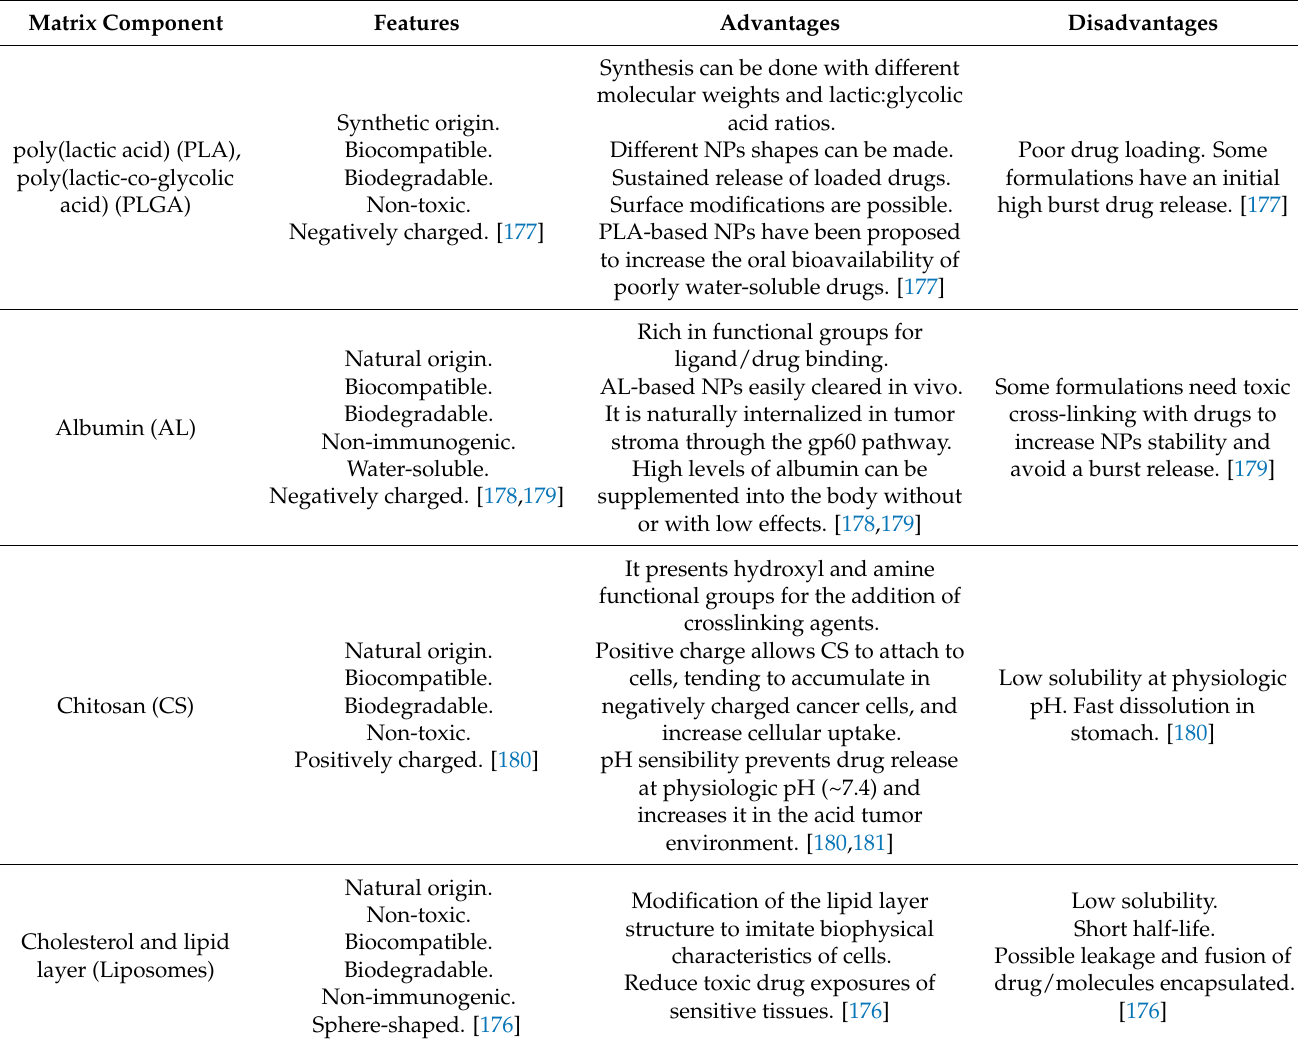
Table 2. The most common matrices for NPs synthesis and their